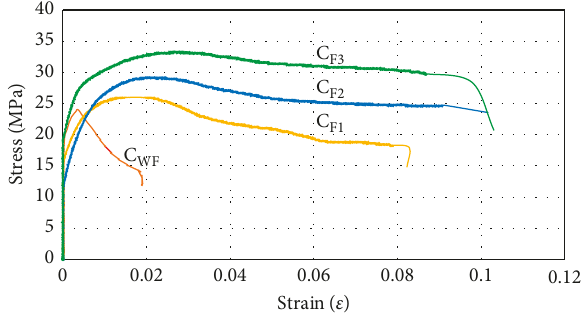
Figure 6: Comparison of experimental stress-strain curves of the specimen with various confinement ratios.